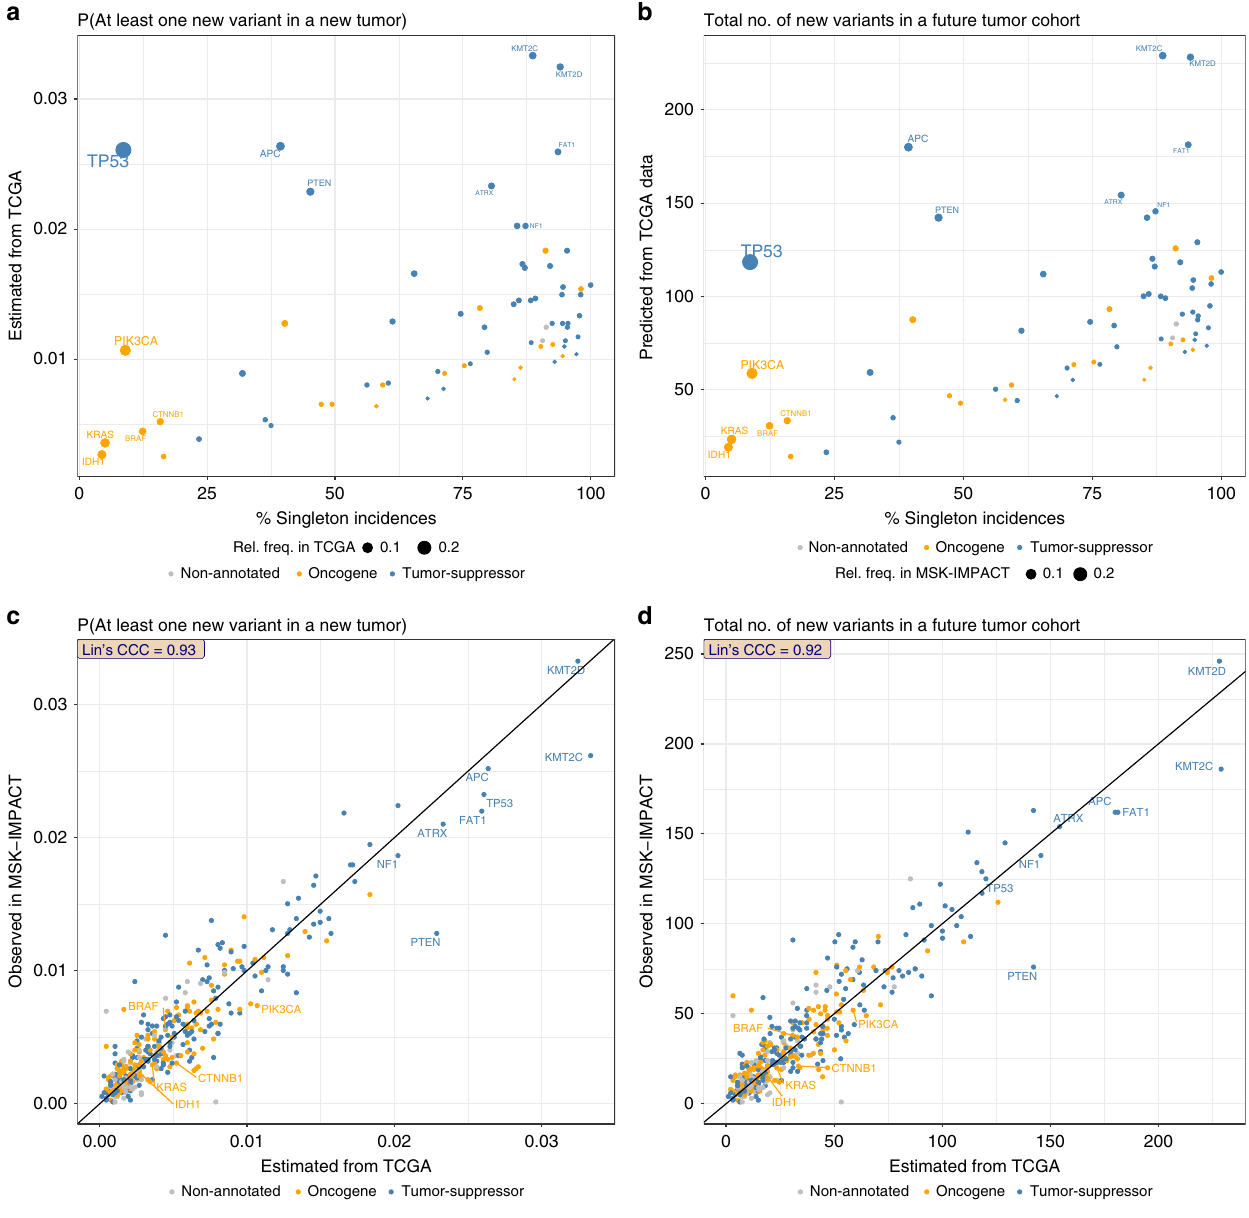
Fig. 4 The estimated numbers and probabilities associated with unseen variants are remarkably accurate. a TCGA data based estimated probability of observing at least one new variant in a new tumor, plotted against the percent singleton incidences (in TCGA data) for each frequent (mutation rate in TCGA data ≥ 0.03) gene that is also in the MSK-IMPACT panel. b TCGA data based predicted number of new variants in a future sequencing cohort of size 7254 (the number of non-hypermutated tumors in MSK-IMPACT cohort), plotted against the percent singleton incidences (in TCGA data) for each frequent gene in MSK-IMPACT panel. c The TCGA estimated probability (the quantity along the vertical axis of panel a ), plotted against the observed relative frequency of at least one new variant in a new tumor in MSK-IMPACT data for all MSK-IMPACT genes. d The TCGA predicted number of new variants in a future study with 7,254 tumors (the quantity along the vertical axis of panel b ), plotted against the observed number of new variants in MSK- IMPACT data, for all MSK-IMPACT genes. Oncogenes are shown in orange, tumor-suppressor genes are in blue, and non-annotated (in OncoKB list) genes are shown in gray. All estimates in this fi gure correspond to tumors in the non-hypermutated subgroups of the respective